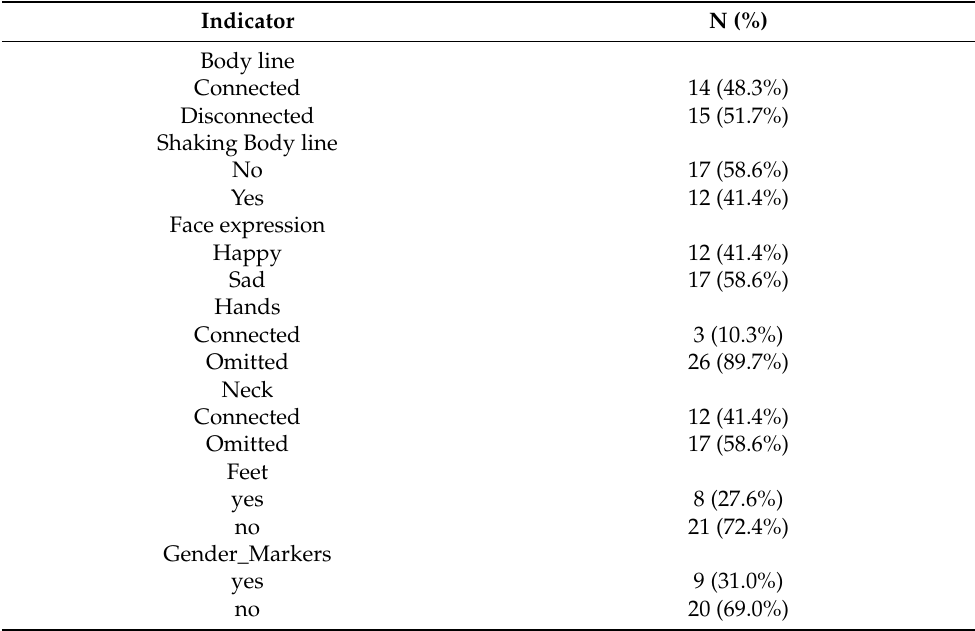
Table 4. All indicators for drawing of the self after diagnosis, N =